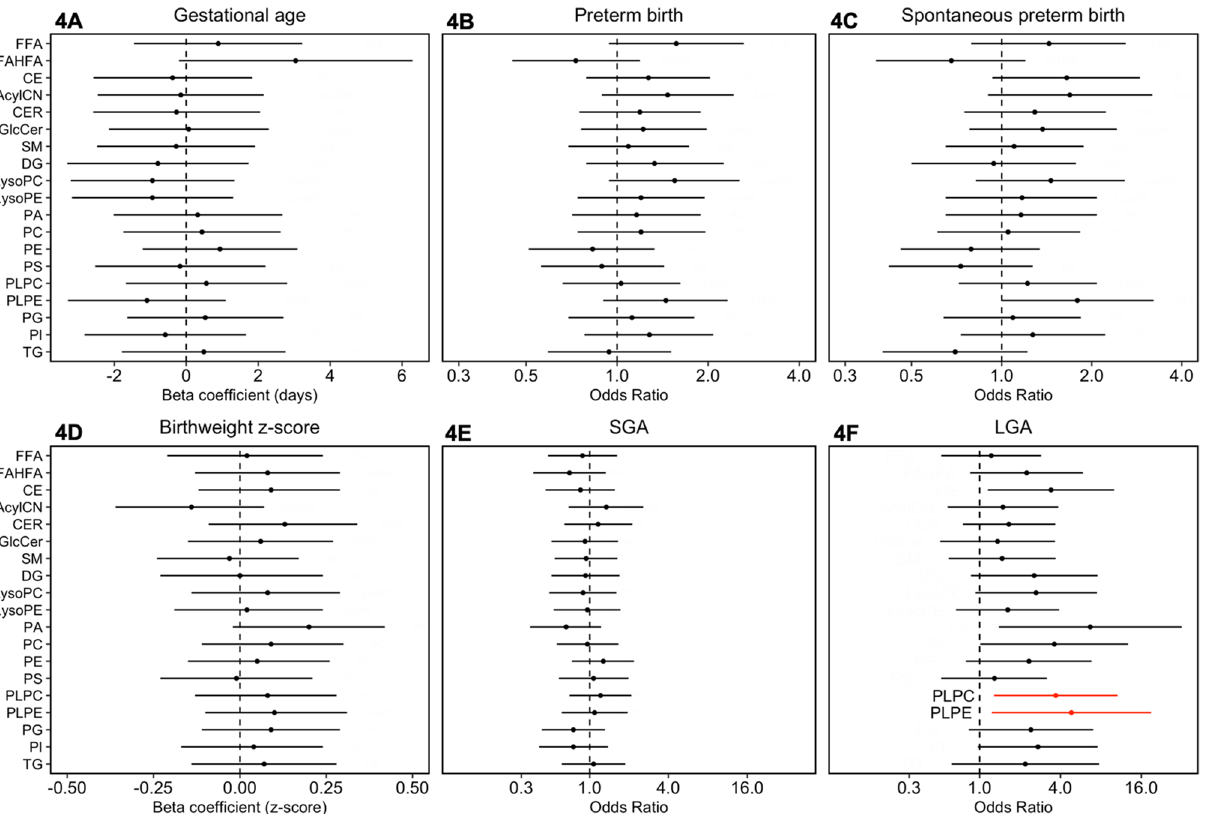
Figure 4. Forest plot of effect estimates of associations between whole lipid classes and pregnancy outcomes: ( A ) gestational age at delivery; ( B ) preterm birth (n cases = 31,n controls = 69); ( C ) spontaneous preterm birth (n cases = 19,n controls = 69); ( D ) birthweight z-score; ( E ) small for gestational age [SGA] (n cases = 16,n controls = 75); ( F ) large for gestational age [LGA] (n cases = 9,n controls = 75). Models adjusting for maternal age, maternal education, fetal sex, pre-pregnancy BMI, and weight gain. Associations highlighted in red have p-values < 0.05, but all associations had corresponding q-values exceeding